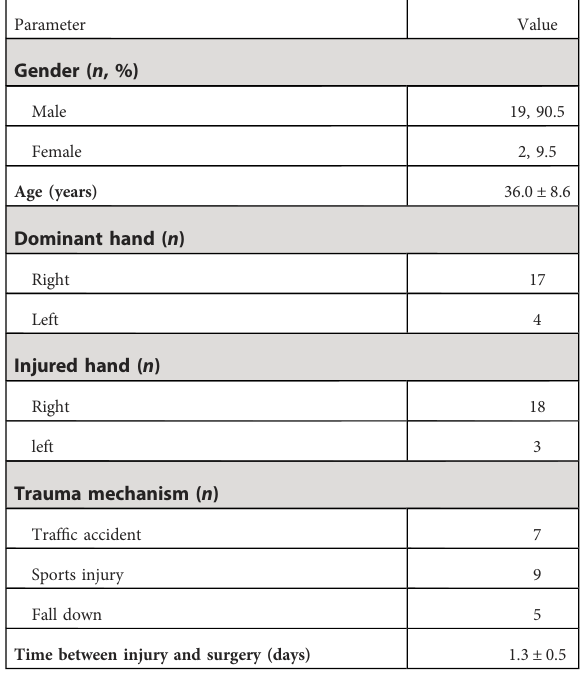
TABLE 1 Demographic data of patients ( n